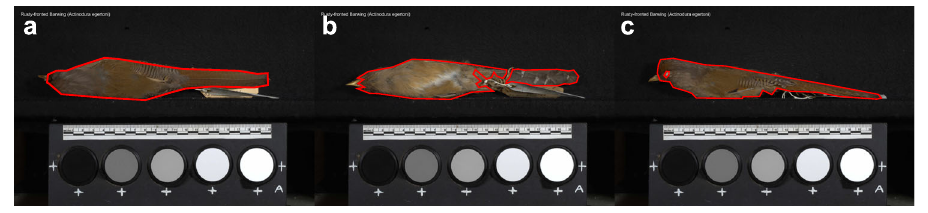
Fig.5|Examplesofusingpolygonstosegmentplumageareasofspecimens.a A specimen is segmented using a single polygon. b A specimen is segmented using